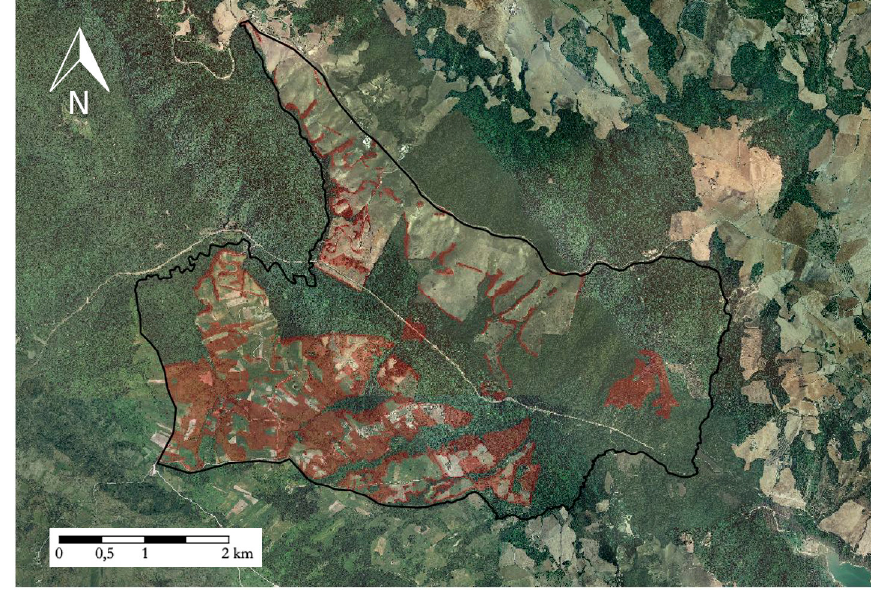
Figure 8. In red, the land transitions from agricultural activities to natural areas in the period from 1955 to